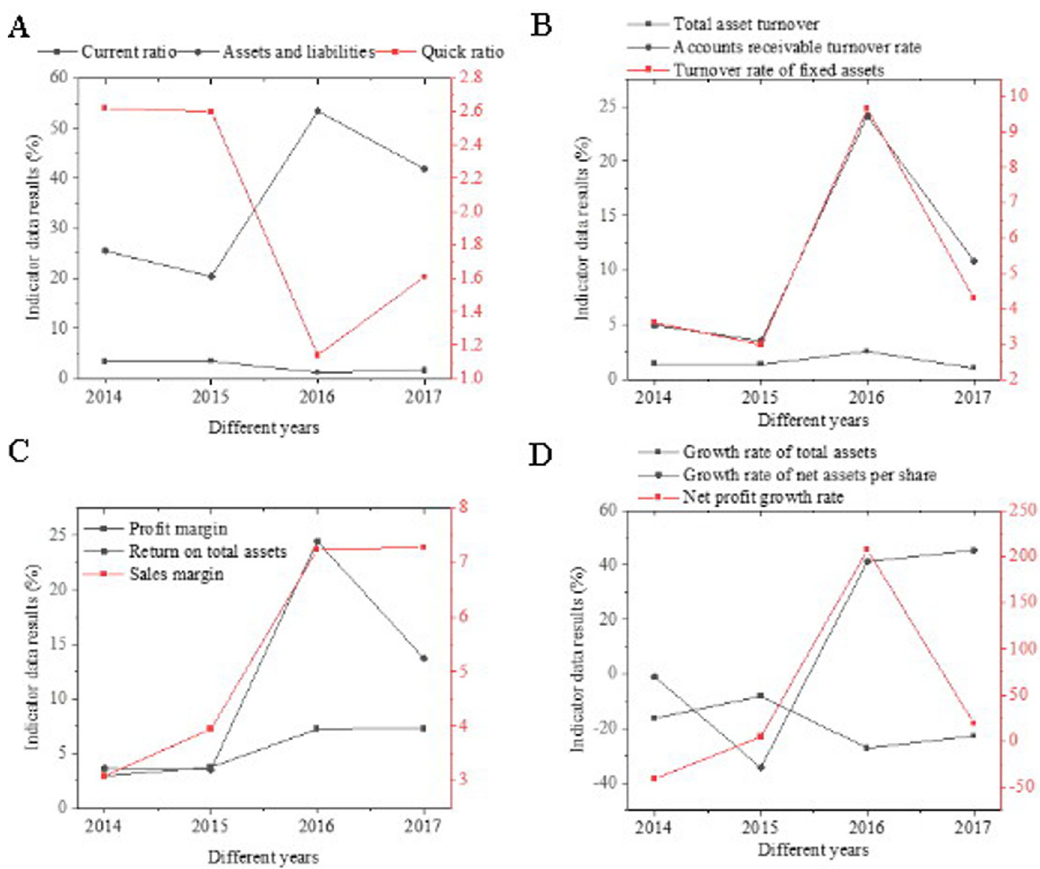
Fig 5. Analysis results of SF’s financial